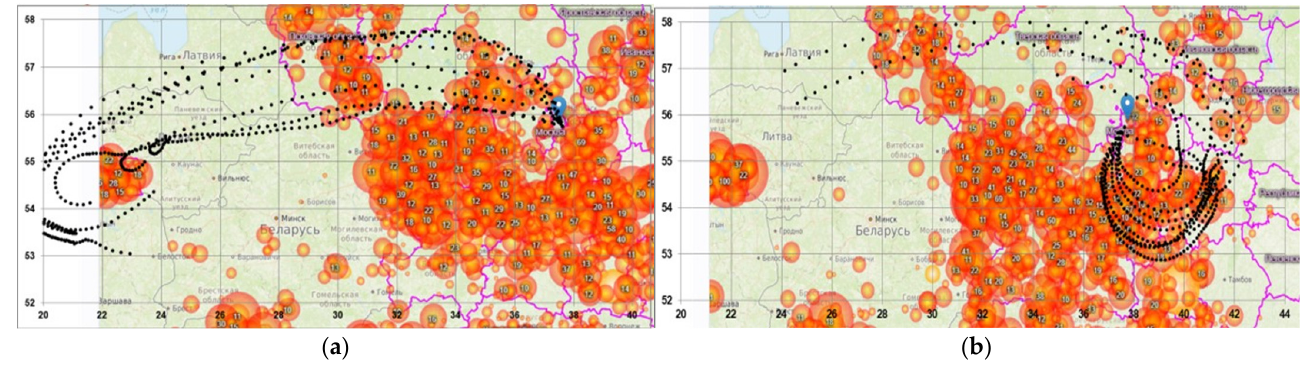
Figure 6. Examples of fire distributions in near-surface atmosphere over ETR territory (according to the data [83]) and trajectories of air mass transport (black dots) to Moscow (blue flyer) for 26